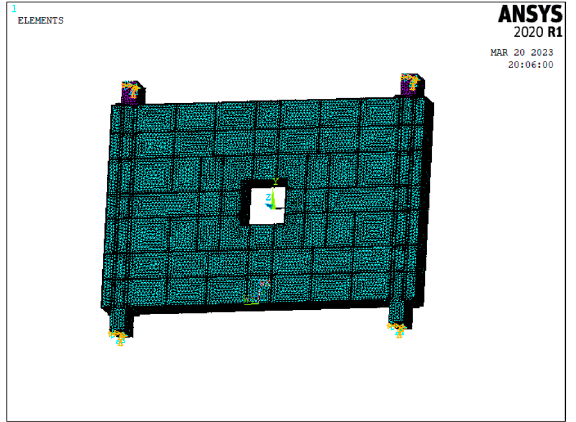
Figure 6. Large body structure constraint diagram.